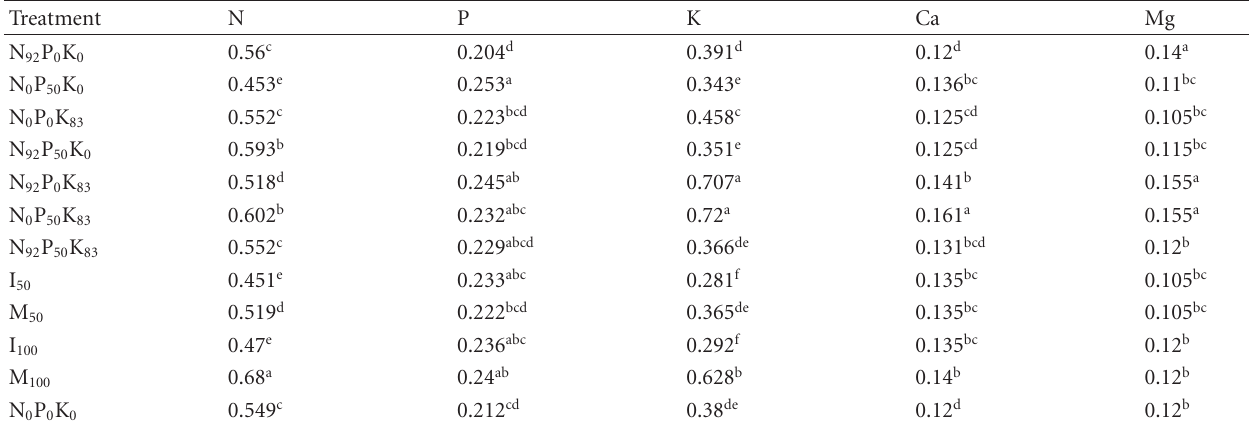
Table 3: Tissue nutrient concentrations for shoot at harvest (%).